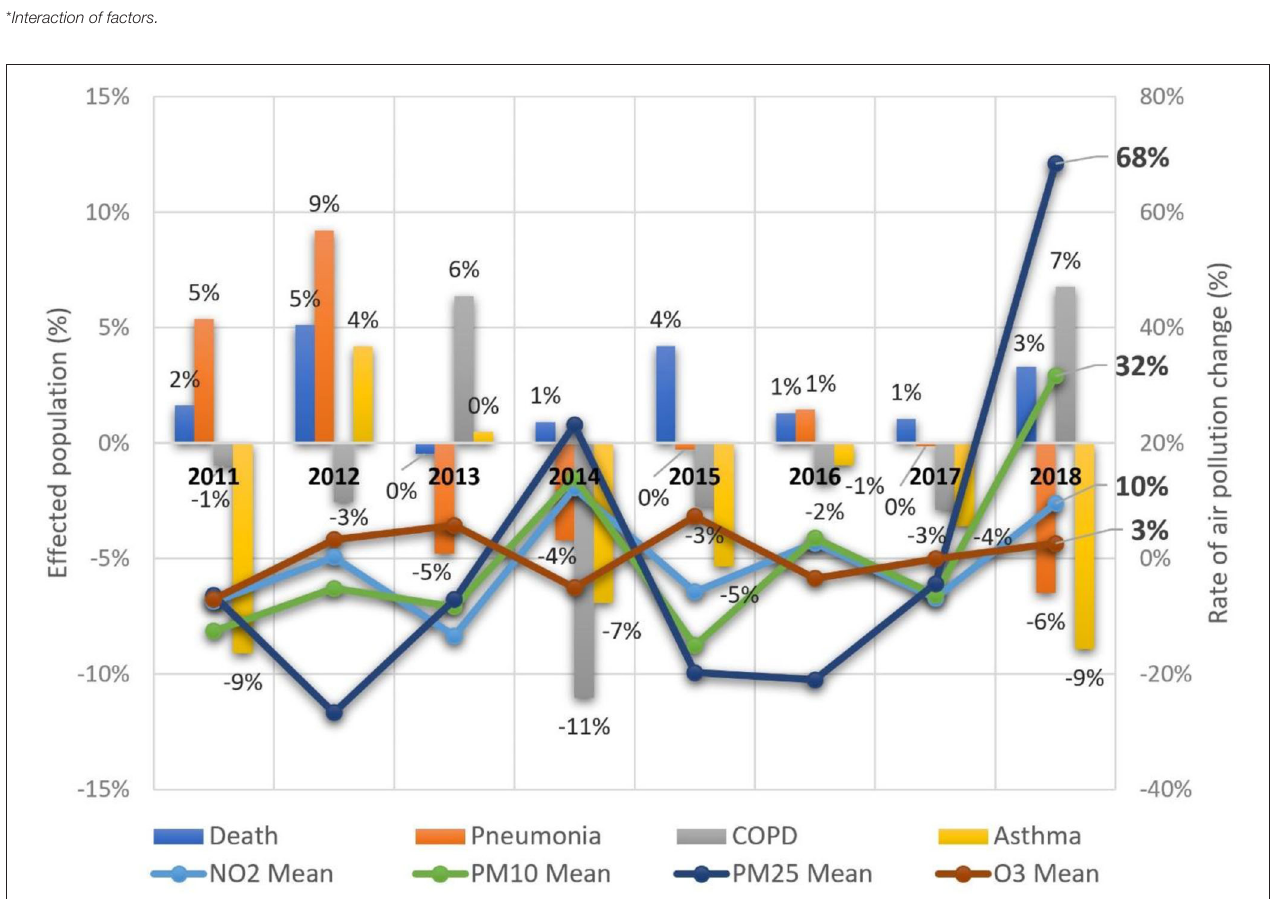
FIGURE 3 | Dynamics of changes in the number of cases and deaths vs. air pollutants in the Tri-City,